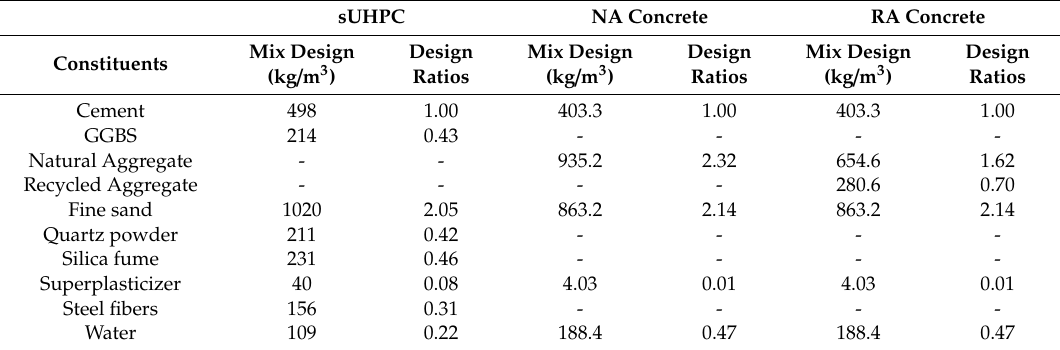
Table 3. Mix designs for sUHPC, normal aggregate (NA), and recycled aggregate (RA)